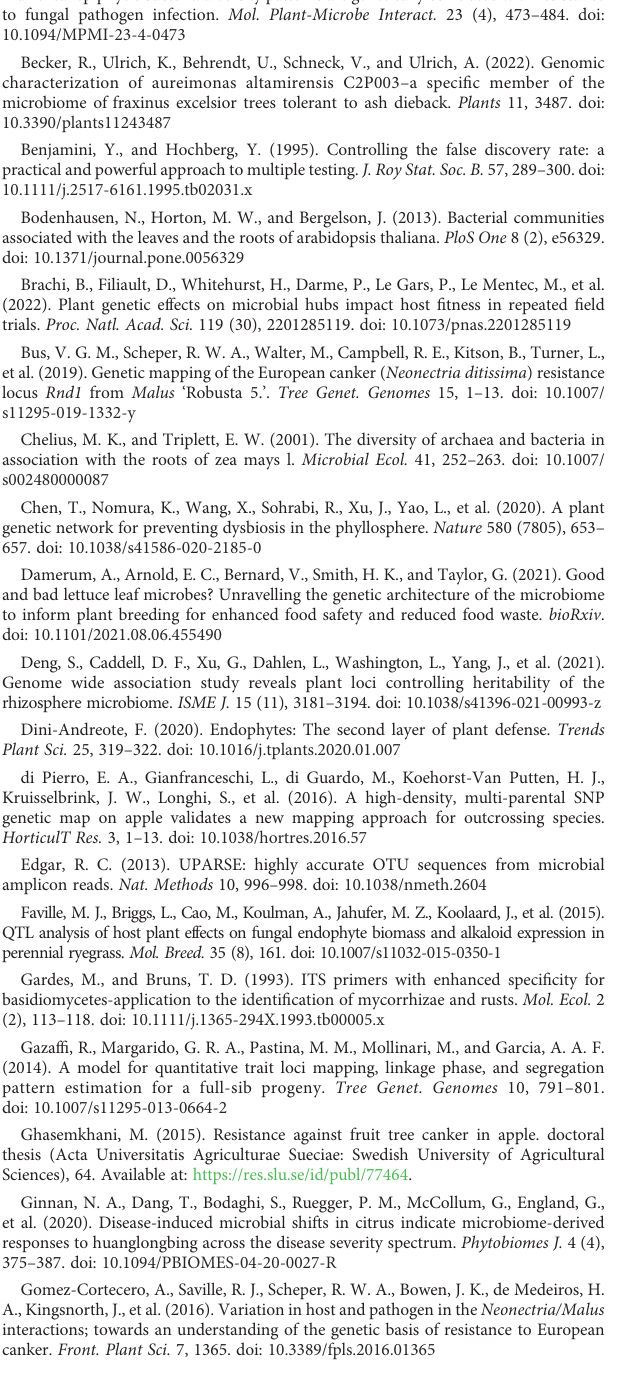
SUPPLEMENTARY FIGURE 1 Histograms of trait distributions in the biparental population. SUPPLEMENTARY FIGURE 2 CorrelationmatrixofPearson ’ scorrelationcoef fi cientbetweenbacterial(ingrey) and fungal (black) abundance traits, and severity of canker disease (in yellow). This data originates from a previous publication by Papp-Rupar et al.